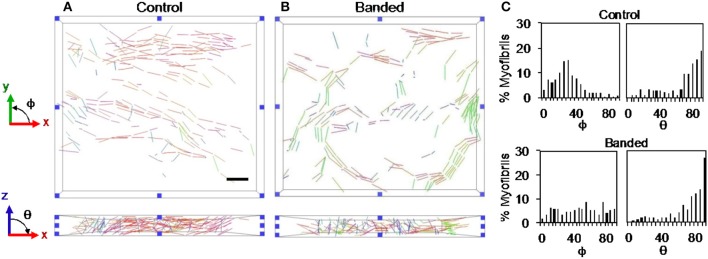
Example myofibril bundle orientation display where each bundle is shown colored based on the orientation in the xy and xz planes for a control (A) and a banded (B) embryo. (C) Example myofibril bundle orientation angle histograms for a control and banded embryo. Scale bar = 2 μm.